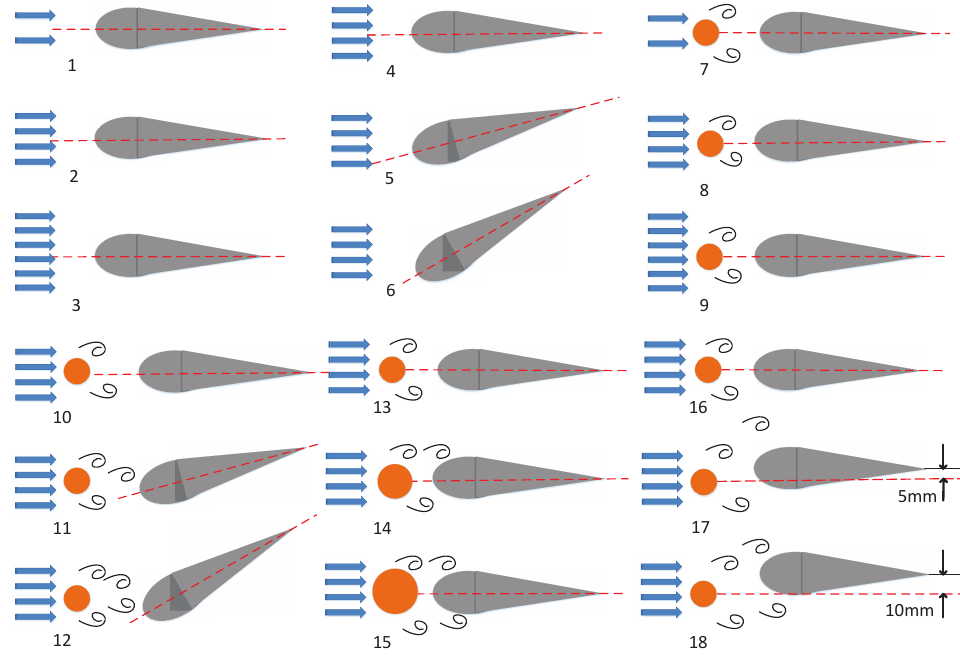
Figure 2. Investigated